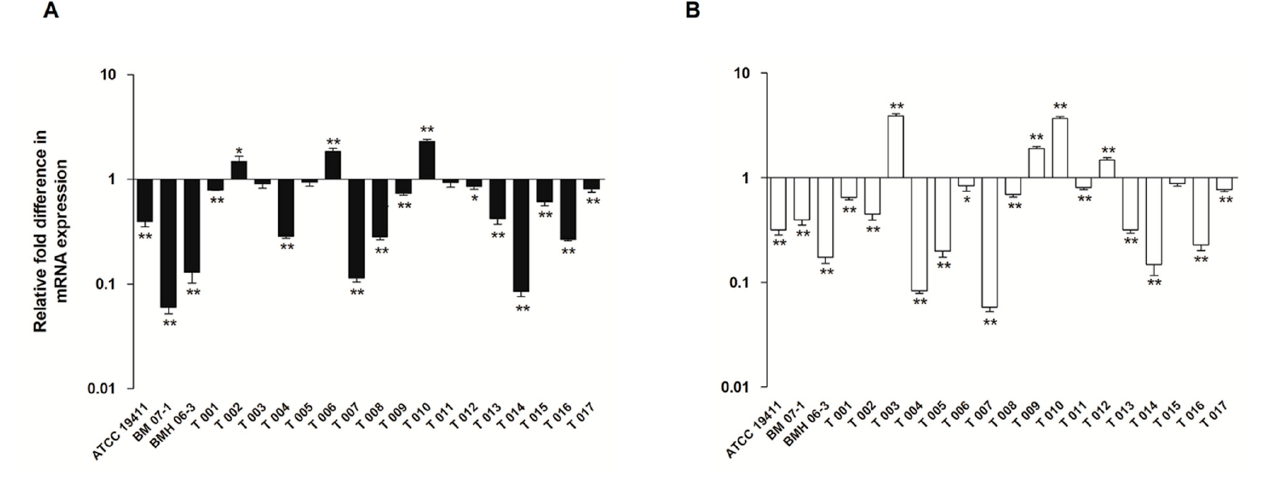
Figure 3. The mRNA expression level of tatD genes in 20 T . pyogenes after luteolin treatment. ( A ) The mRNA expression of tatD960 , ( B ) the mRNA expression of tatD825 . T . pyogenes treated with luteolin at 1/2 MIC. Data were presented as means ± SD. (* compared with control, * p < 0.05, ** p < 0.01).